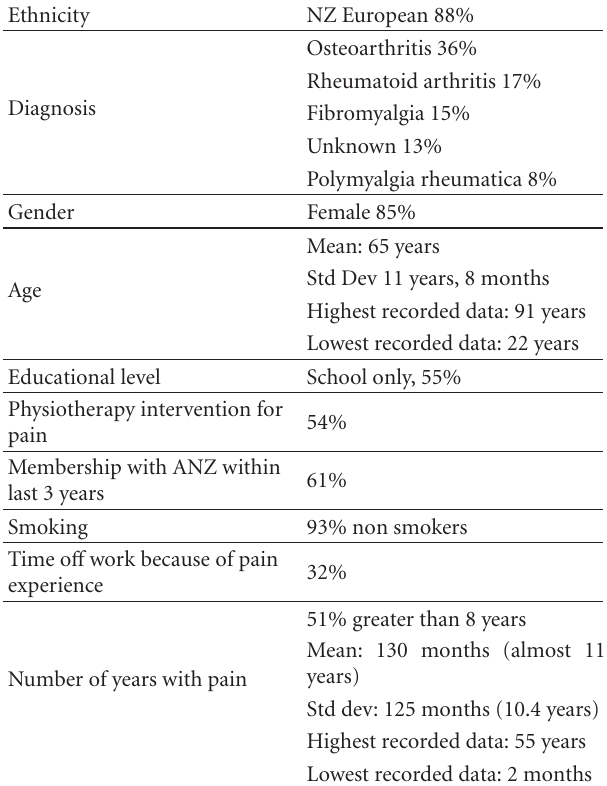
Table 2: Demographic predominant percentage